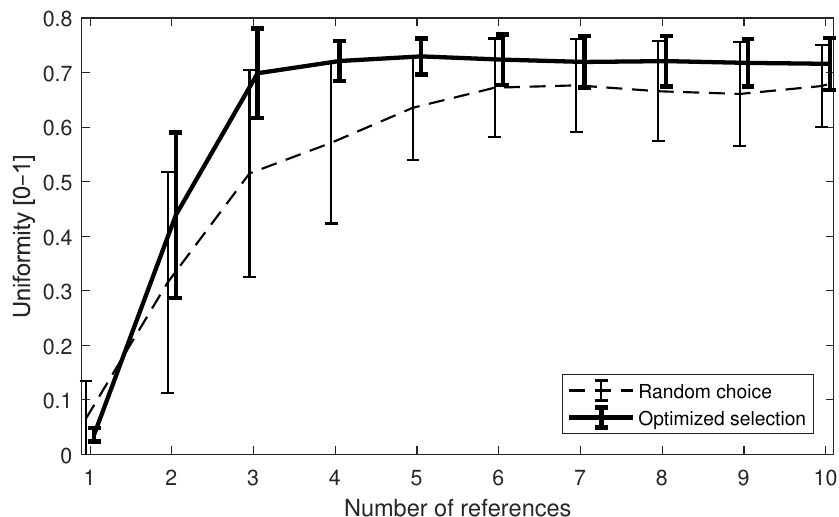
Figure 3. The power distributed in particular output modes depends on the number of references used for calibration. The uniformity U (see Equation (4)) of the mode intensity is depicted with a solid line together with a standard deviation interval. The uniformity obtained when using an optimised reference mode selection is compared with a uniformity obtained when using a random choice of